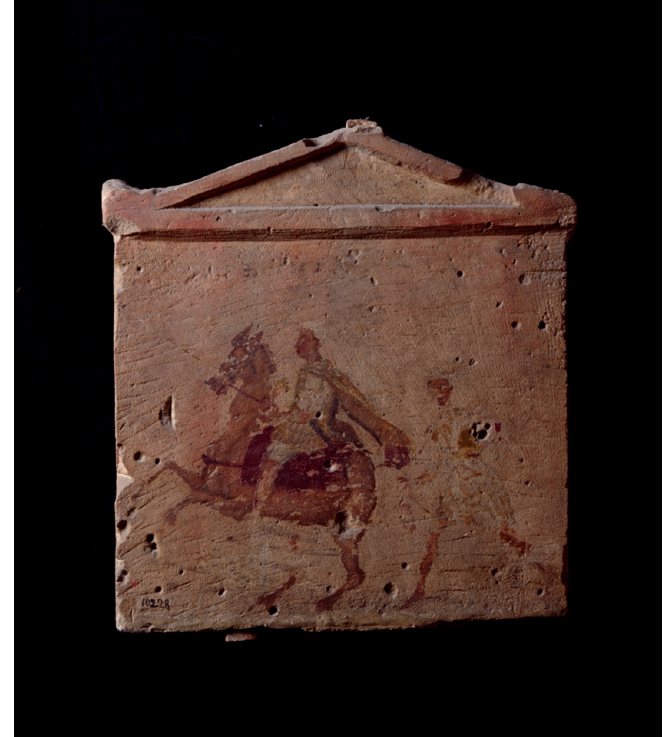
Figure 6. Funerary Stela of a Soldier on Horseback. © Centre d'Études Alexandrines.